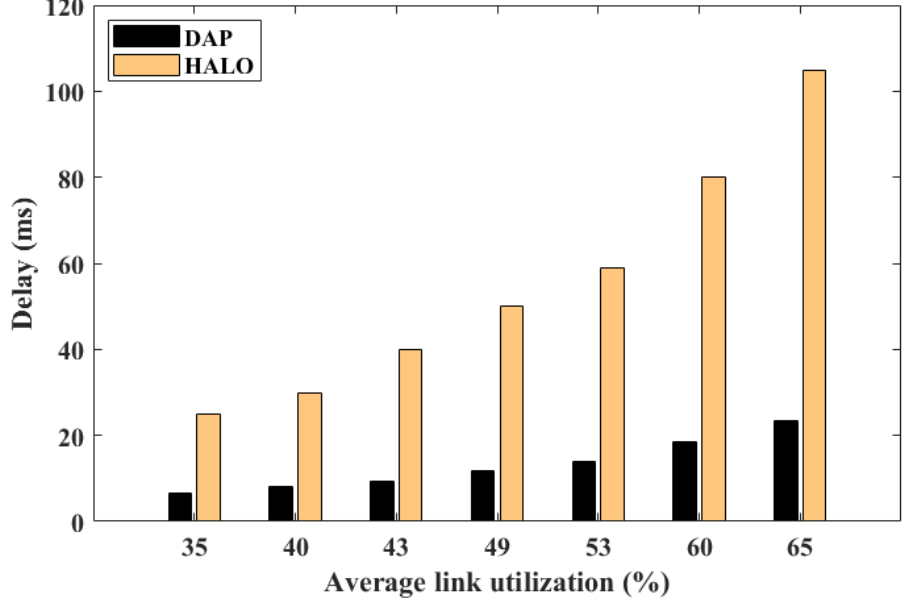
Figure 9. Time to attain optimal value for the DAP algorithm and HALO algorithm over varying link